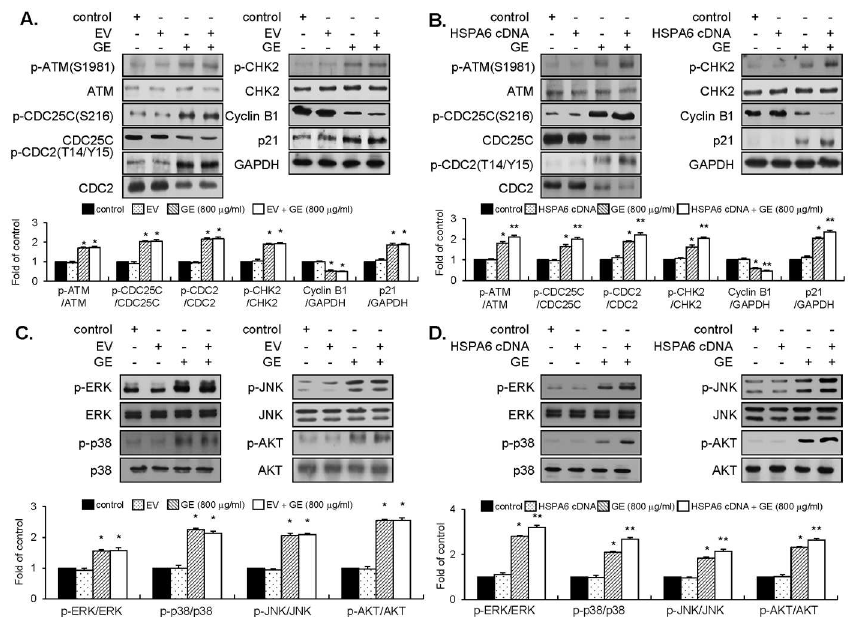
Fig 6. HSPA6 gene enhanced regulatory proteins participated in GE-mediated G 2 /M-phase cell cycle and early signaling pathways in EJ cells. EJ cells were transfected with an EV (A, C) or HSPA6 (B, D) followedby incubation in the culture medium with or without GE. Cell cycle regulatorsand signalingmolecules were assessed by immunoblots using specific antibodiesindicated. Expression levels of proteins were normalized by corresponding total forms or GAPDH. * P < 0.05, comparedwith the control and ** P < 0.05, comparedwith GE